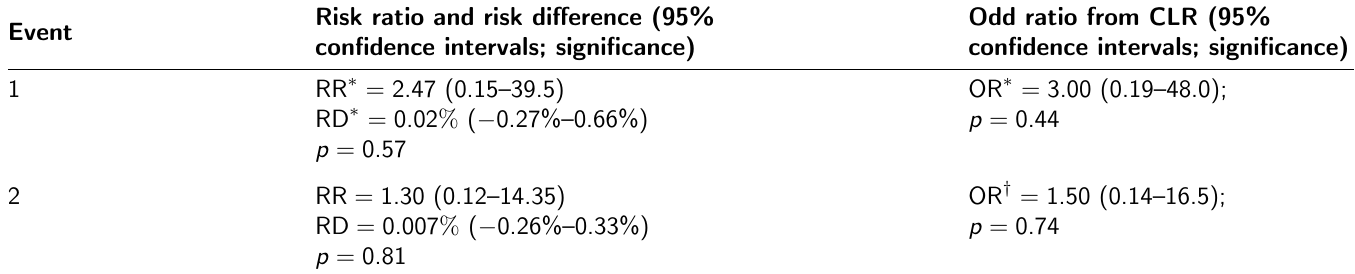
Table S2: Results of RR and CLR analysis of unexposed cohort B using paired-substitution